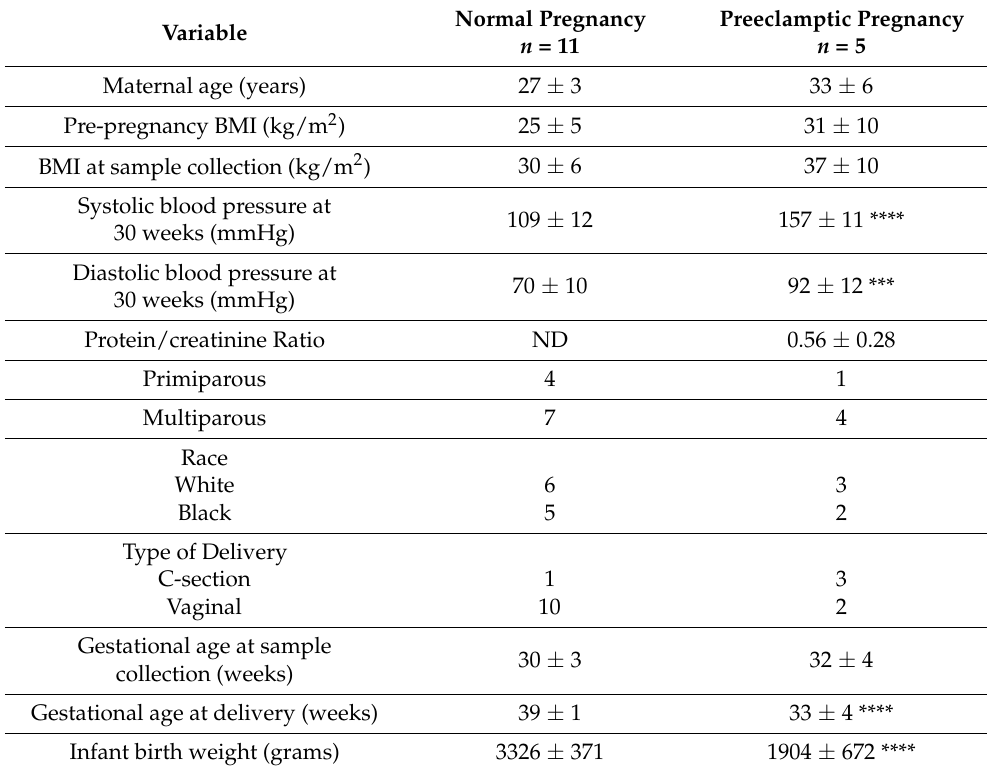
Table 1. Clinical Characteristics of Study